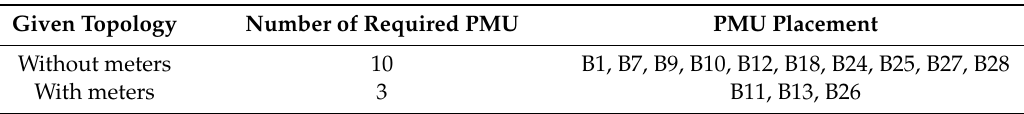
Figure 6. Probability of finding the attack vector in IEEE 30-bus system.